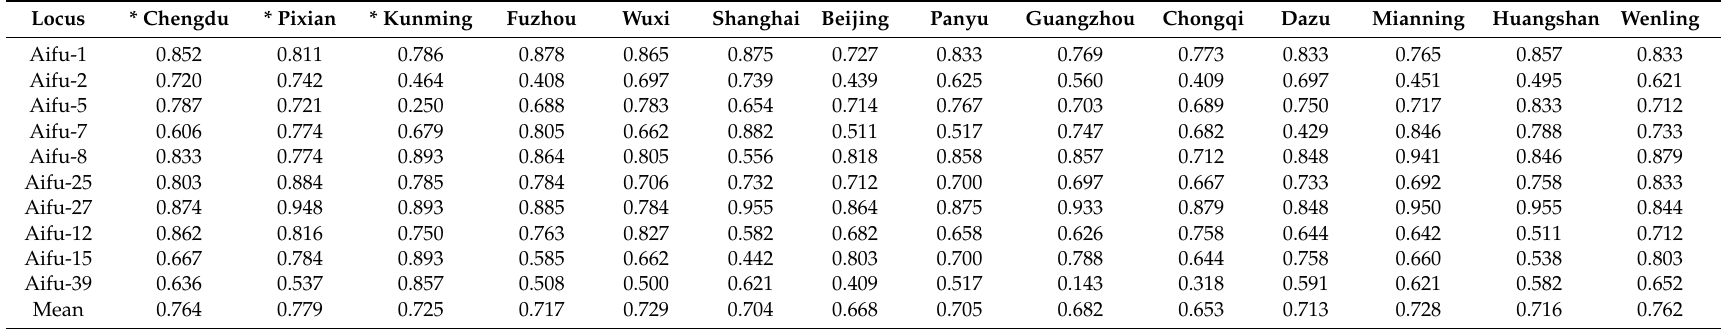
Table 3. The comparison of mean expected heterozygosity from captive populations. * Source: Liang (2007). Locus